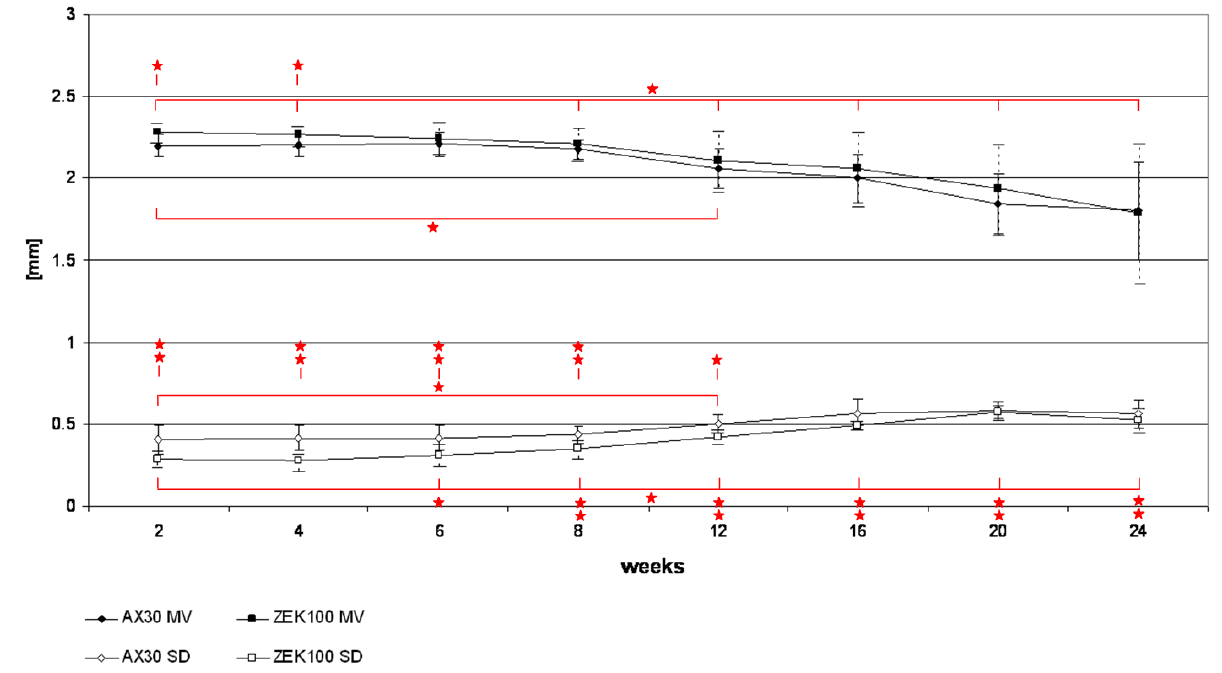
Figure 4. Measurements of the direct 3D thickness of the implants during the implantation measured by the